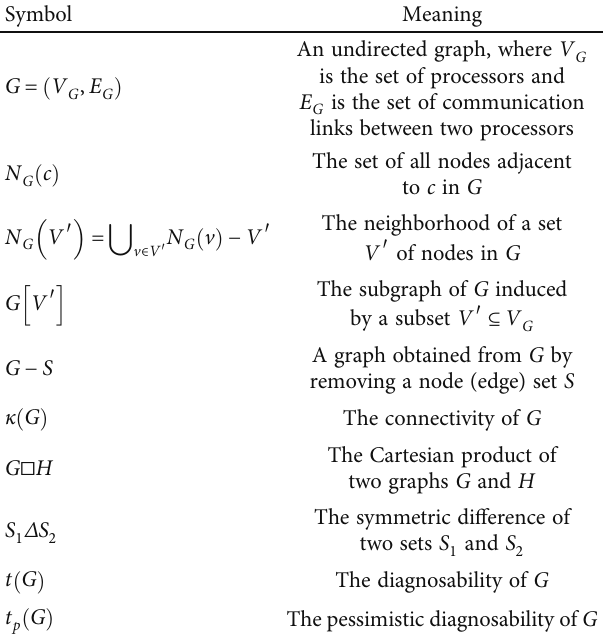
Table 2: Notations.